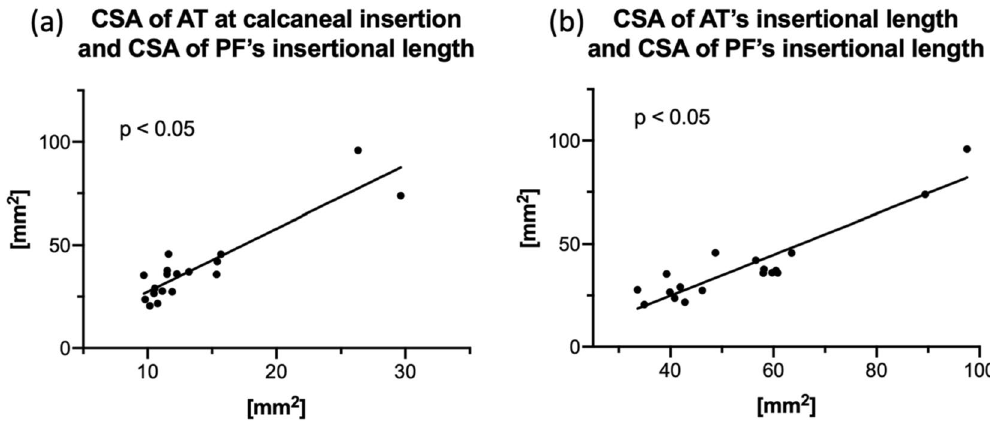
Figure 4. Graph ( a ) shows the cross-sectional area (CSA) of the Achilles tendon (AT) at calcaneal insertion in relation to the CSA of plantar fascia’s (PF) insertional length (r = 0.80, p ≤ 0.001). Graph ( b ) shows the CSA of AT’s insertional length in relation to CSA of PF’s insertional length (r = 0.84, p ≤ 0.001).